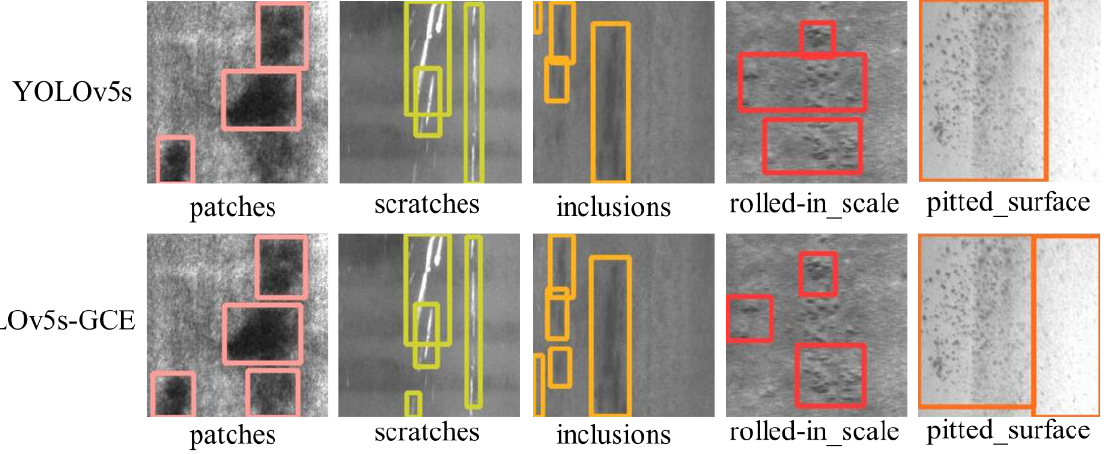
Figure 8. Comparison of detection effects.